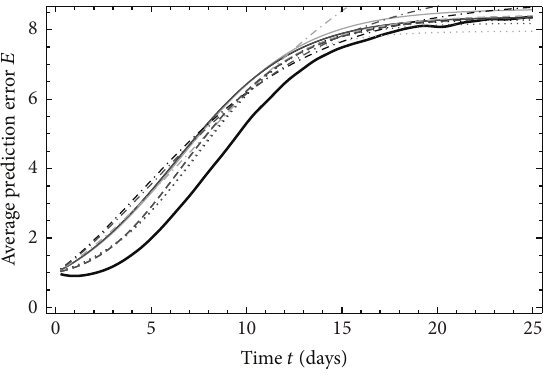
Figure 4: As Figure 2 for ND 5 , 𝑀 5 .